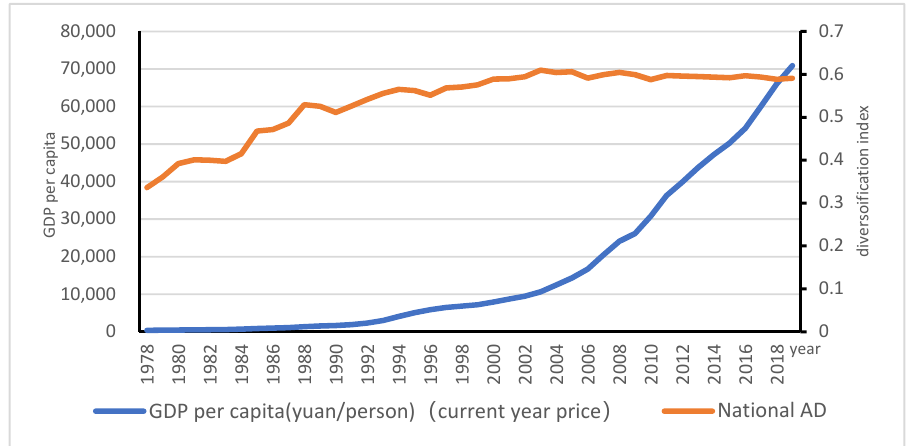
Figure 5. The relationship between AD and economic growth.